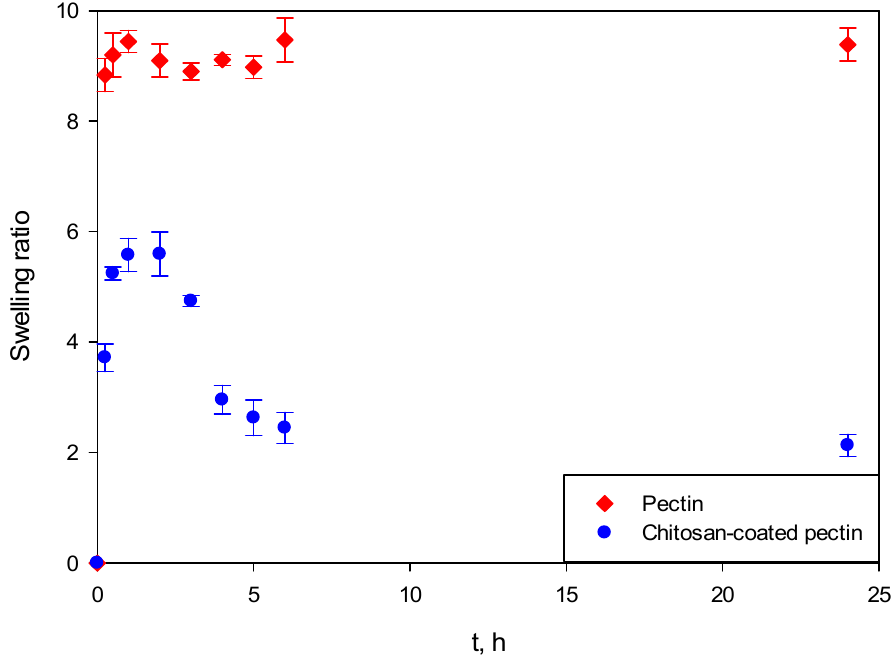
Figure 8. Swelling behavior of pectin aerogel and chitosan-coated pectin aerogel in SGF at pH = 1.2 for 24 h.